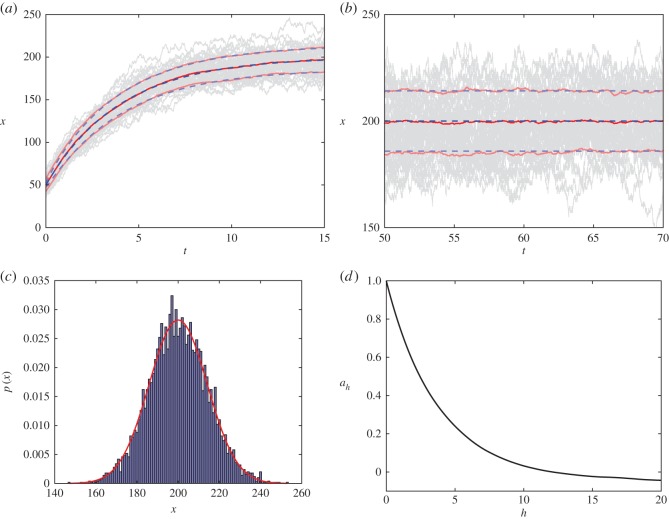
Illustration of the dynamics of the simple box model. (a,b) Time-series trajectories of stochastic simulation realizations (grey) and the corresponding averages in red. The mean predicted from theory is illustrated in dashed blue. (c) A histogram of the ensemble at t=60 and (d) the autocorrelation at different lags h. More details are included in the main text.